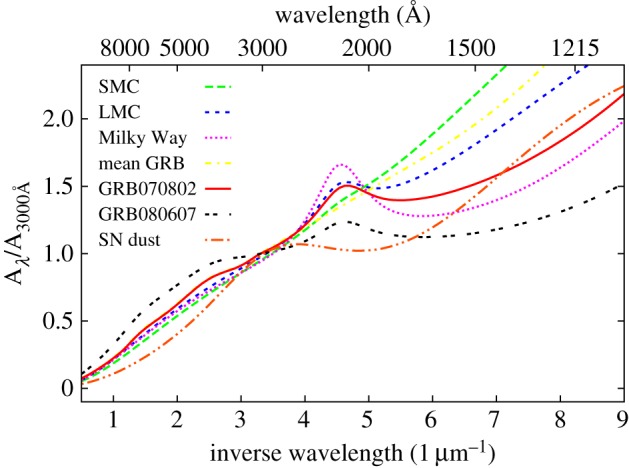
Average extinction curves from numerous lines of sight to the SMC (large-dash; green), the LMC (small-dash, blue), to the Milky Way (dots; pink), and to a sample of GRBs (dot-dash yellow; [233]). The figure also shows the extinction curves best-fit to the SED of GRB 070802 (solid red; [231]), GRB 080607 (blank-dash black; [275]) and the theoretical extinction law from SN-produced dust (dot-dot-dash orange; [276]).